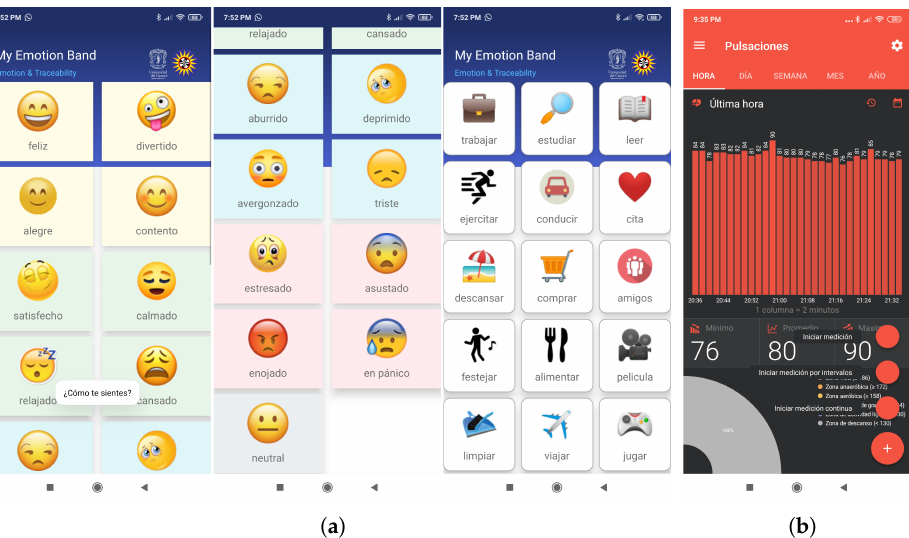
Figure 6. The mobile app’s graphic interface used by the participants: ( a ) MyEmotionBand for recording emotional state, activity, and location; ( b ) MFB [45] for HR